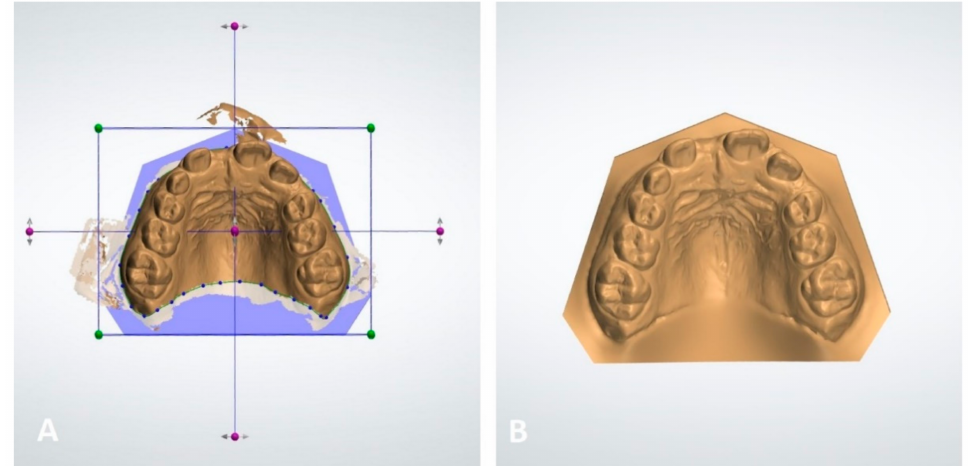
Figure 1. Processing of an intraoral scan to a digital model: ( A ) Removal of noise at the edges, and virtual placement within a digital socket. ( B ) Completed digital model (software: Appliance Designer, 3Shape).